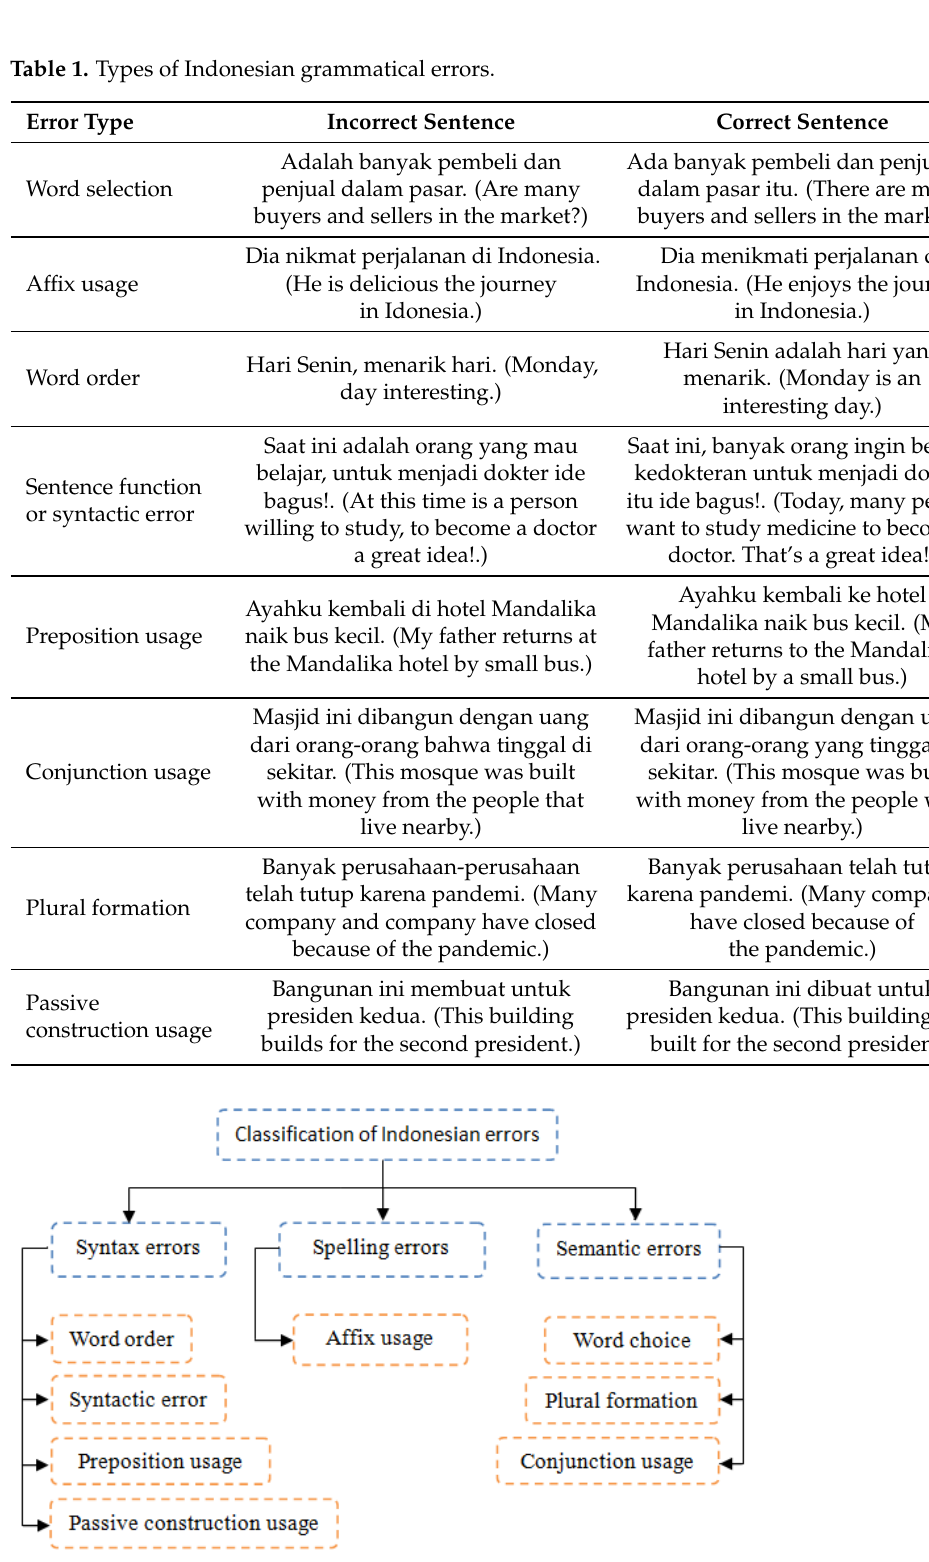
Figure 2. Indonesian error classification scheme for the GEC